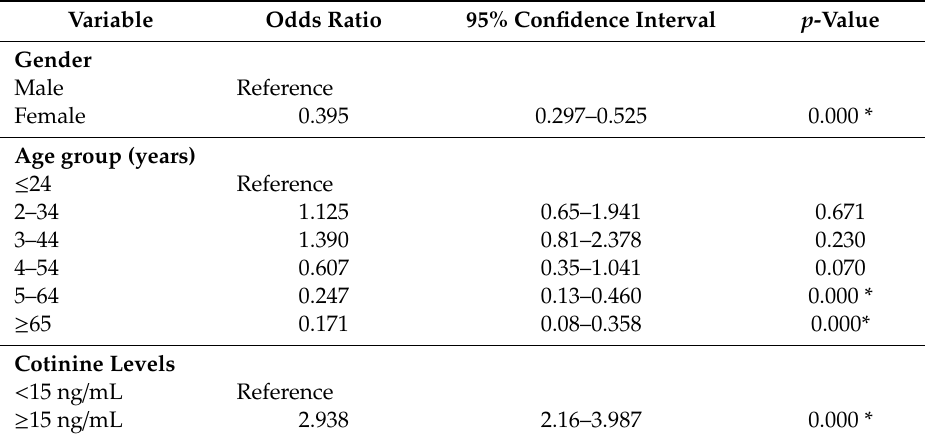
Table 1. Association of Oral Mucosal Lesions and gender, age category, and cotinine levels.